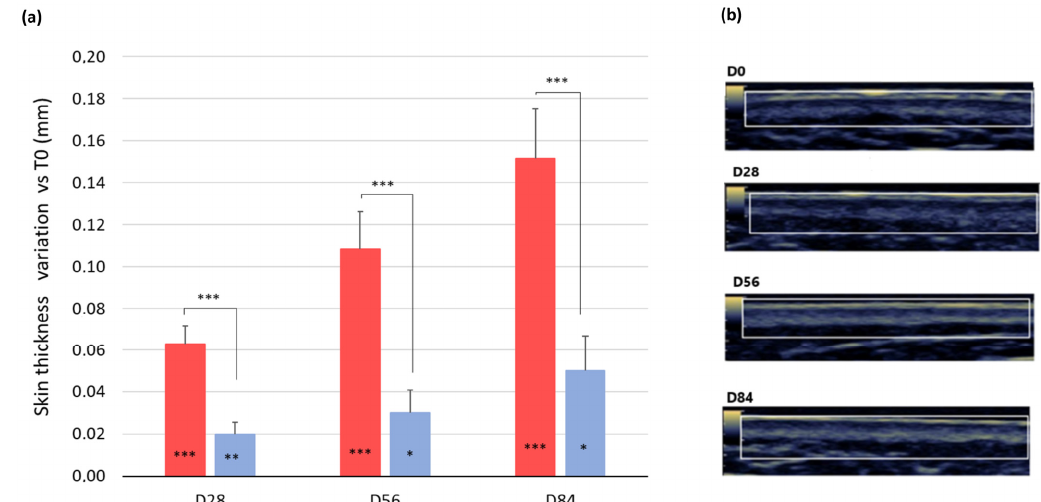
Figure 6. Effects on skin thickness. ( a ) Skin thickness variation versus baseline after 28, 56, and 84 days in the treatment (red bars) and in the placebo group (blue bar). Data are means ± SEM. Intragroup (vs. 0) statistical analysis is reported inside the bars. Intergroup (vs. placebo) statistical analysis is reported on the bars. Statistical analysis is reported as follows: * p < 0.05, ** p < 0.01, and *** p < 0.001. ( b ) Representative skin echography images of one volunteer before and after 28, 56, and 86 days of treatment with the EY ingredient. Pictures were acquired by means of an Aloka Alpha 6 Pro-Sound (Hitachi) ultrasound. The analyzed skin region (dermis + epidermis) is inside the square.